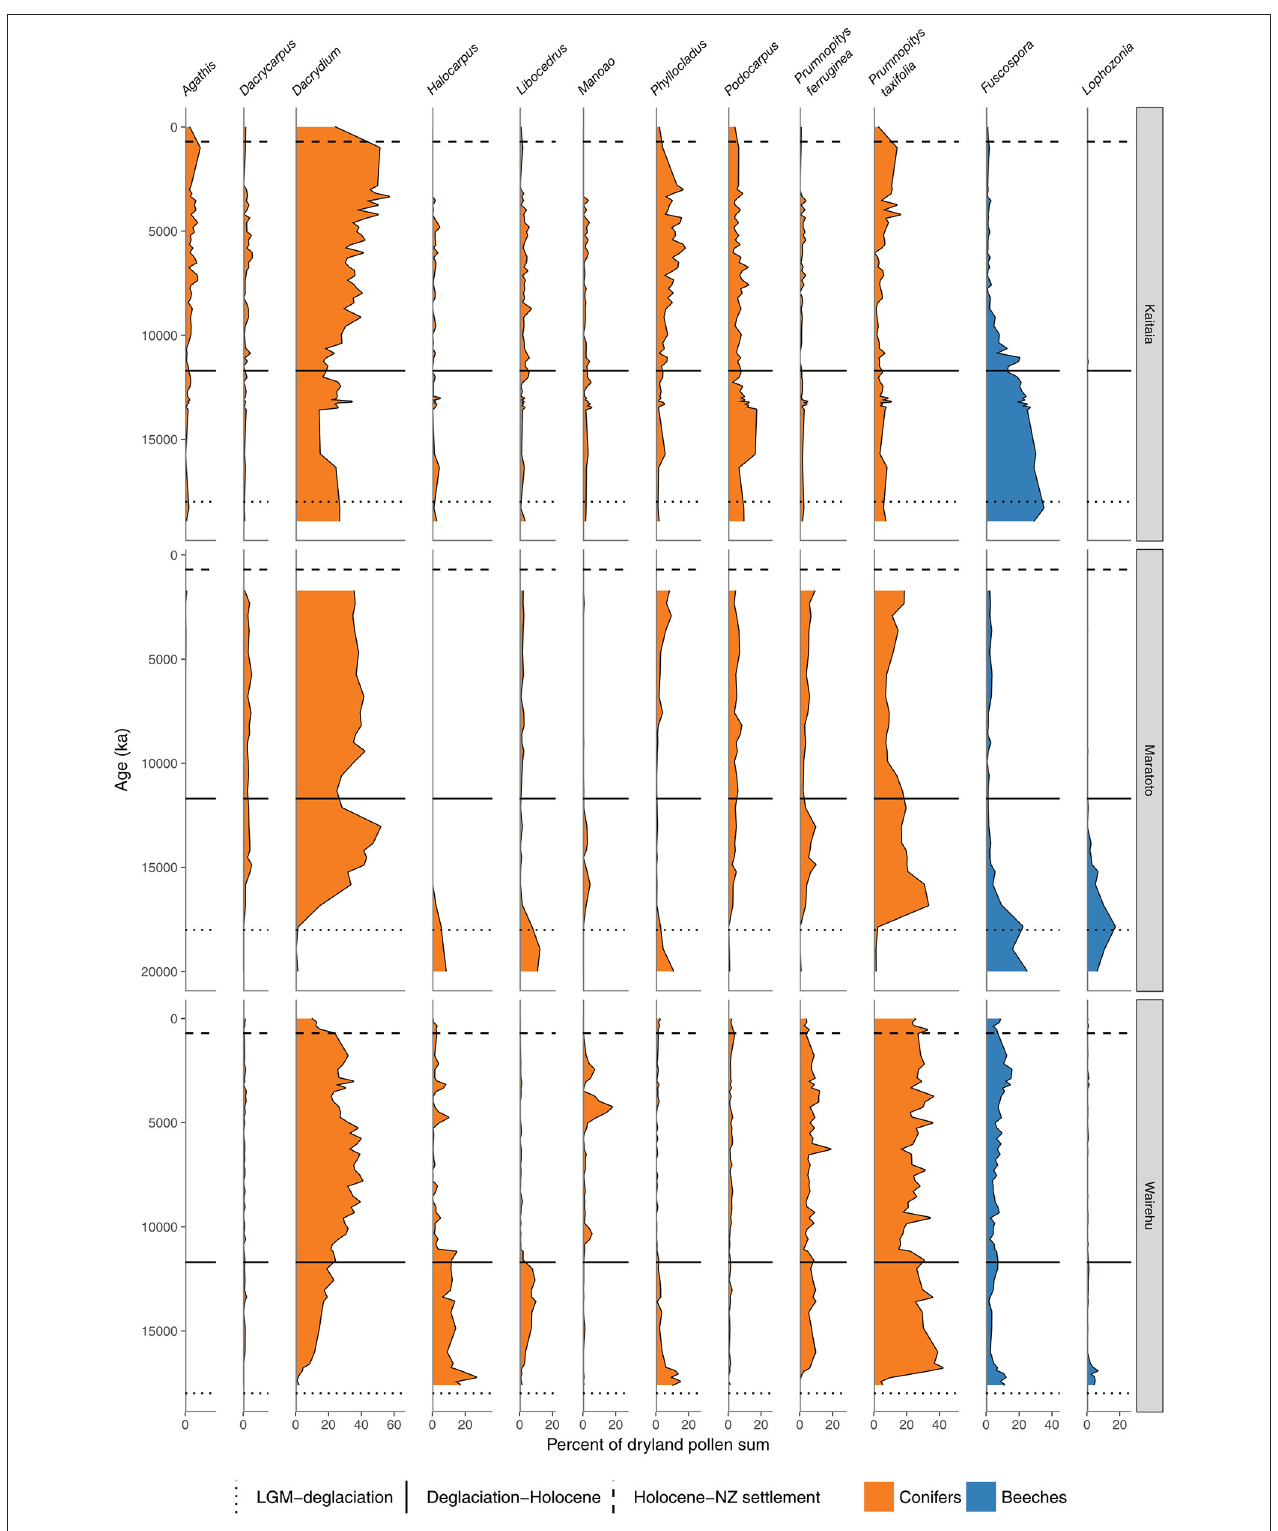
FIGURE 5 | Conifer and Nothofagaceae pollen sequences. Kaitaia bog, Northland (Elliot, 1998). Lake Maratoto, Hamilton Basin (McGlone, 2001a). Wairehu, Rotoaira Basin (McGlone and Topping, 1977).